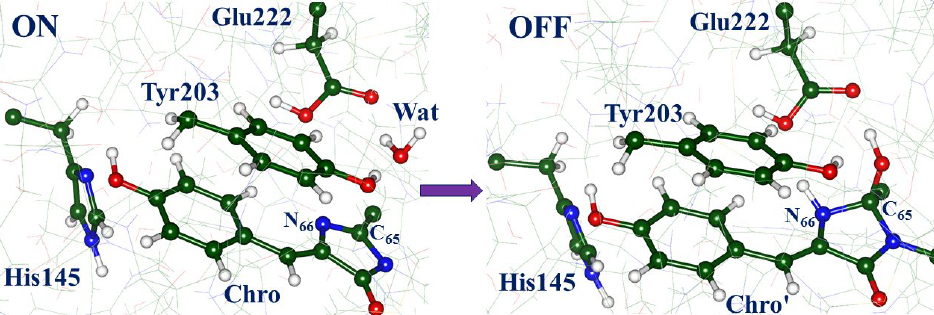
Figure 1. Fragments of protein structures corresponding to the ON- (left) and OFF- (right) states in Dreiklang, illustrating the reactants and the products of the hydration reaction. In this and in other figures, carbon atoms are shown in green, oxygen in red, nitrogen in blue, hydrogen in white.